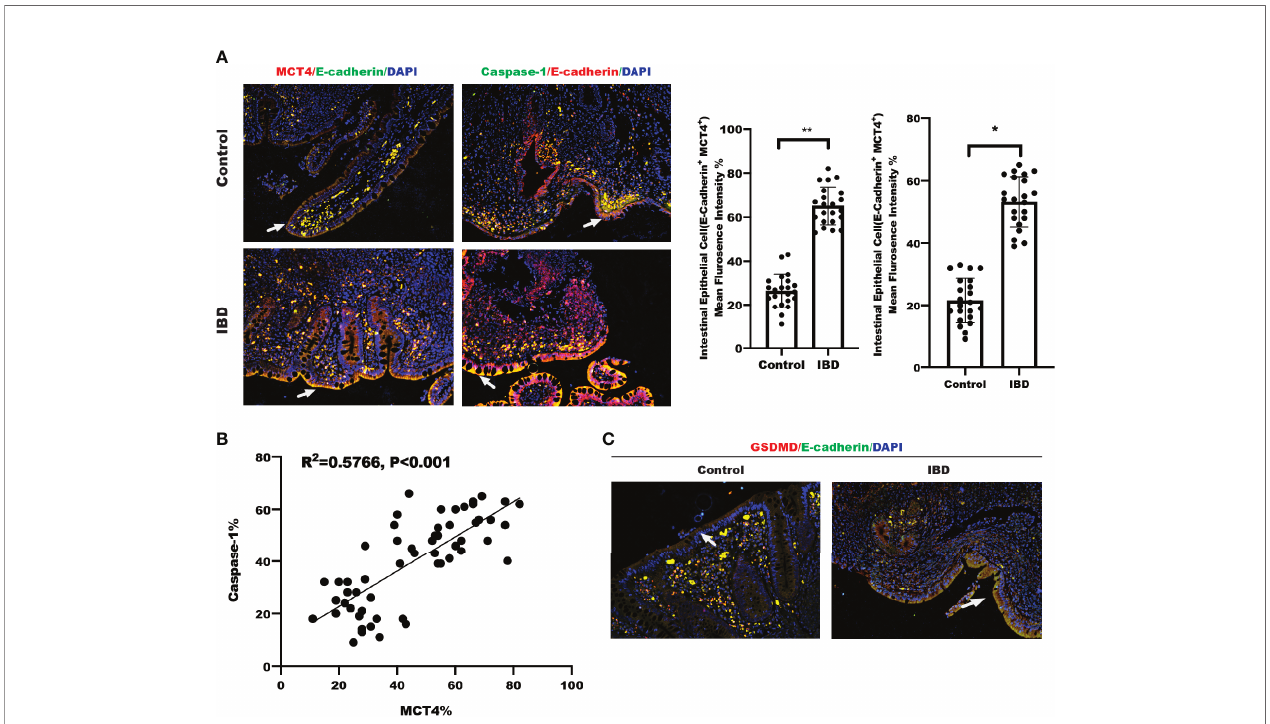
FIGURE 4 | Clinical relationship between MCT4 and Caspase-1. (A) Immuno fl uorescence of MCT4 and Caspase-1 expression in intestinal epithelial cells labeled E- cadherin in Control group (n = 24) and IBD group (n = 24), respectively; the relative immuno fl uorescence intensity of MCT4 + E-Cadherin + and Caspase-1 + E-Cadherin + in intestinal epithelial cells was quanti fi ed by Image J and analyzed by t test. Data represented the mean ± s.d., **p < 0.01, *p < 0.05. (B) Clinical correlation between MCT4 and Caspase-1 expression was generated and analyzed by simple linear regression. (C) IF of GSDMD expression in intestinal epithelial cells labeled E- cadherin in Control group (n = 24) and IBD group (n =